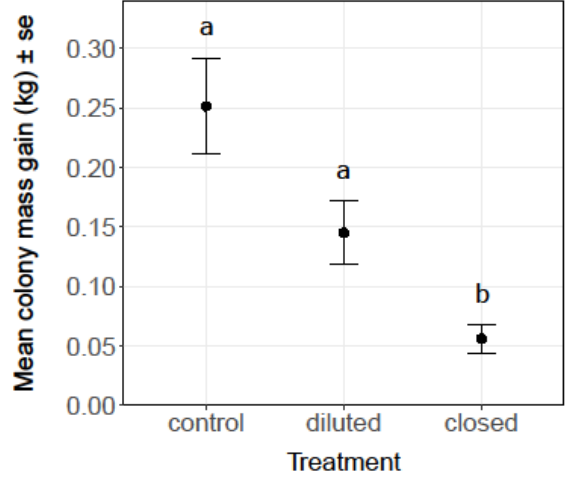
F IGURE 1. Mean nest traffic (number of B. terrestris entering and leaving the colony) in the 30-minute colony observation periods for colonies within the three treatment groups. Circles indicate back- transformed least square means ± standard error. Means sharing the same letter are not significantly different from each other at the .05 significance level. Control treatment colonies (N = 7) had an unaltered internal nectar reservoir (60% sugar concentration), diluted treatment (N = 7) had a diluted reservoir (40% sugar concentration), and the closed treatment (N = 7) had no access to an internal nectar reservoir.